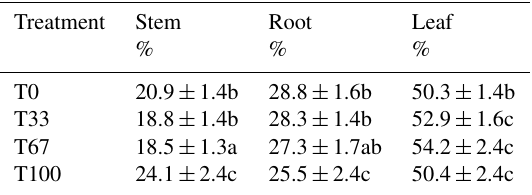
Table 2. Percentage biomass allocation to leaves, stems, and roots on seedlings of Ulmus pumila var. sabulosa exposed to various sand burial treatments during a 45-day growth period. These treatments included sand burial of seedlings to a depth equivalent to 33 (T33), 67 (T67), or 100% (T100) of the mean seedling height at the ini- tiation of the study. Each histogram is the mean ± 1SE of n = 15. Different letters above histograms among seed burial depths are sig- nificantly different at P <0.05.